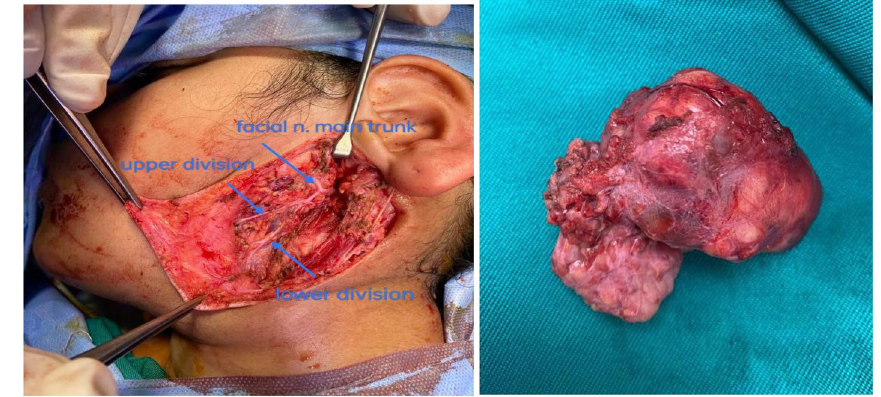
Fig. 1 Pleomorphic adenoma: operative field, and specimen